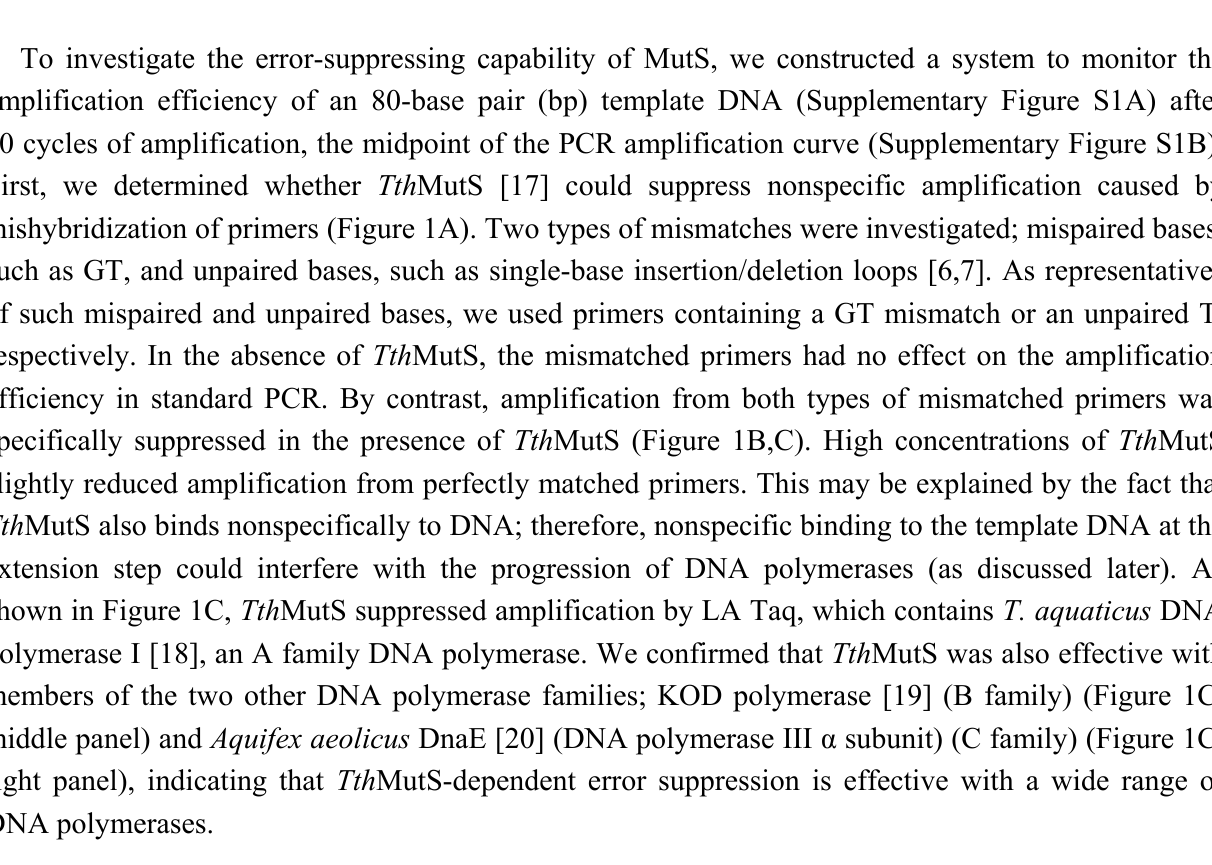
Figure 1. Effects of Tth MutS on standard polymerase chain reaction (PCR)